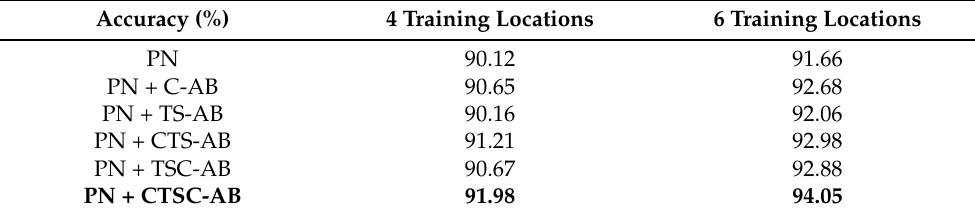
Table 4. The average accuracy for different attention mechanisms. 4 Training Locations